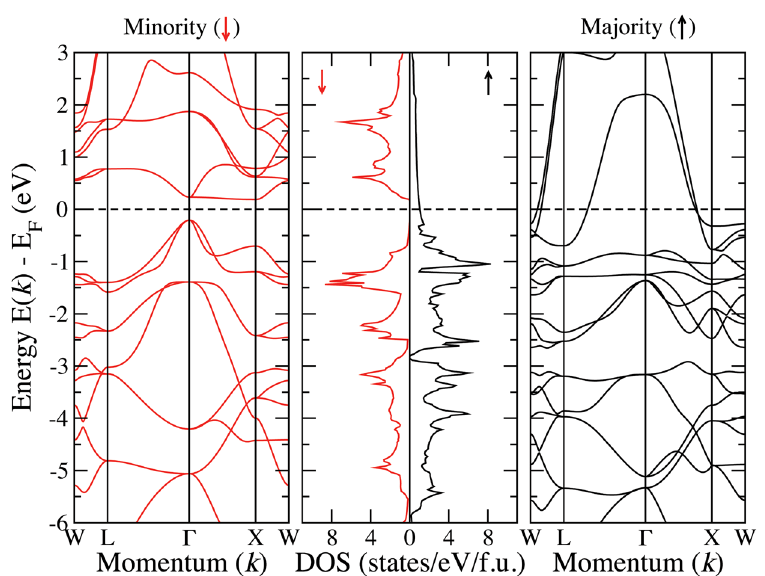
Figure 10. Spin-resolved band structure and density of states for CoRhMnSi.